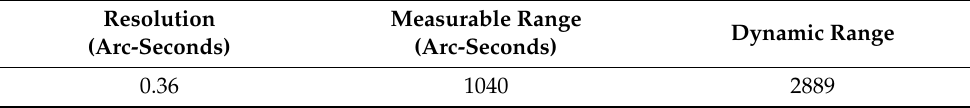
Table 6. The characteristics of the angle measurement method in [24].